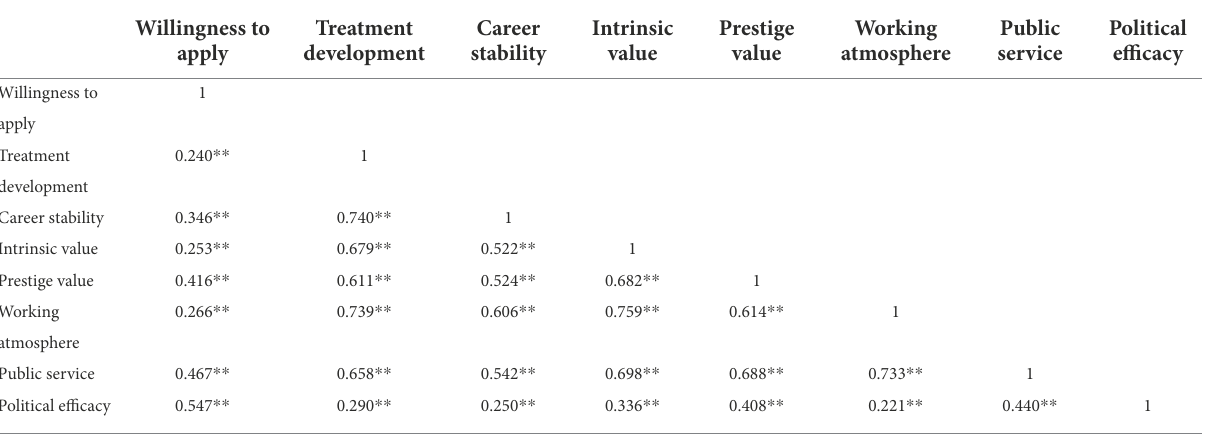
TABLE 5 Correlation analysis of Pearson’s coefficient of each